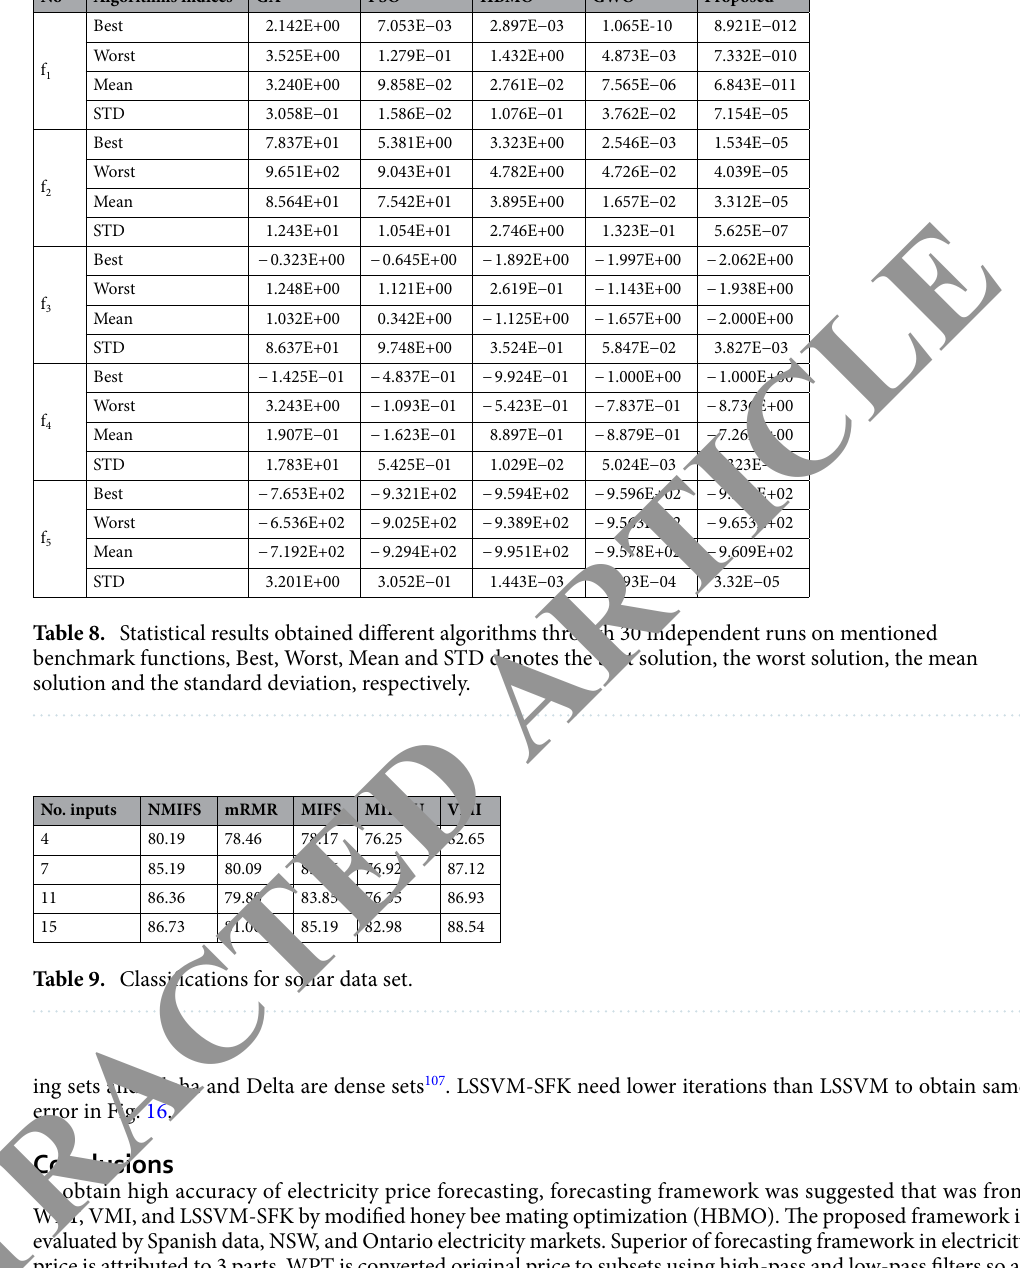
Table 9. Classifications for sonar data